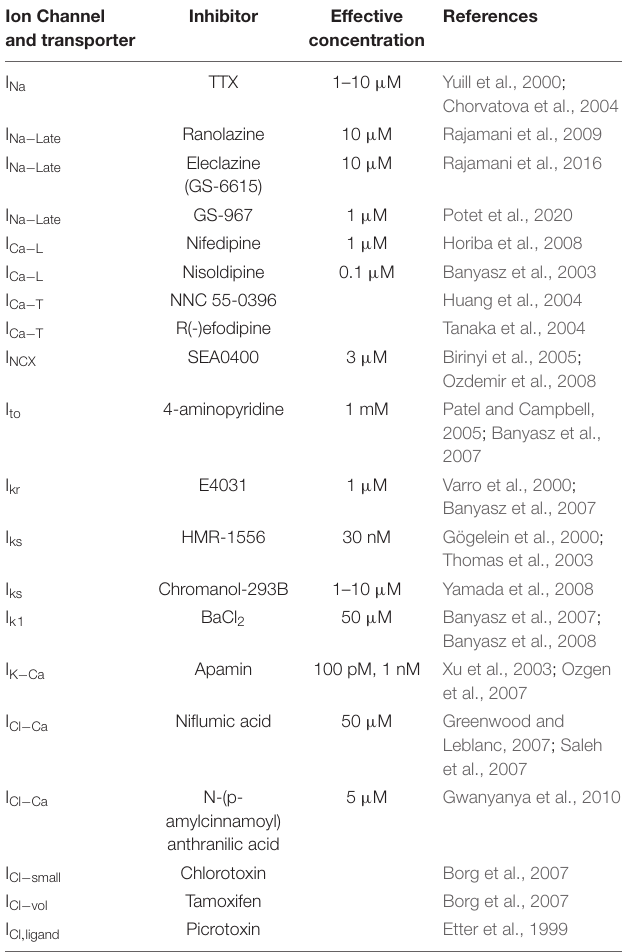
TABLE 1 | Specific inhibitors for the major ionic currents in cardiac